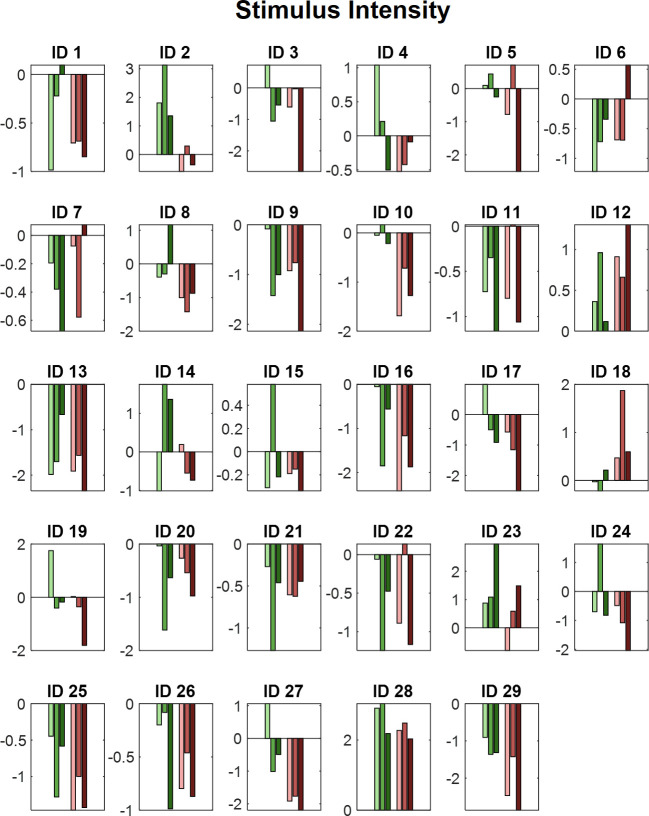
Power values for all medium and high intensity conditions with a valid modality cue.(Expect heat receive heat) averaged over all significant time–frequency–electrode samples period for each subject (ID) of the negative stimulus intensity cluster of the analysis of the reduced model. Green colors represent medium heat conditions and red colors represent high heat conditions. Color intensities depict expectation level.